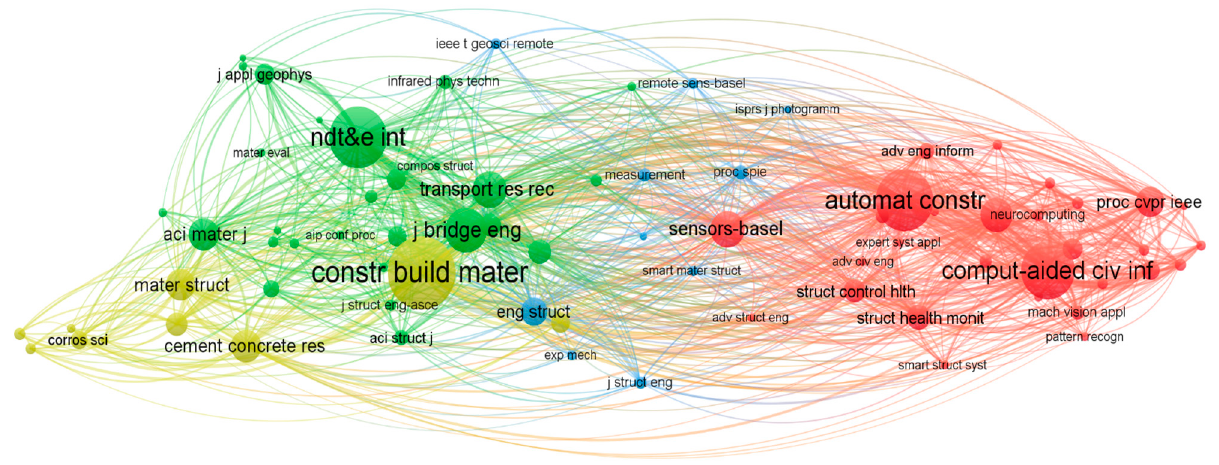
Figure 8. Co-citation network of journals in the research on CBD_NDT.